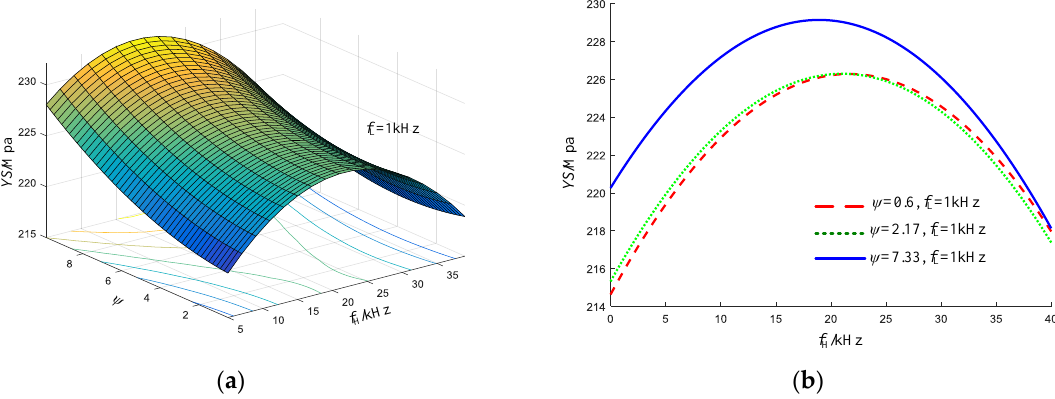
Figure 6. Contour plot of surface on yield strength ( YS ): ( a ) contour plot of surface that f L is 1 kHz; ( b ) interaction of f H and ψ.